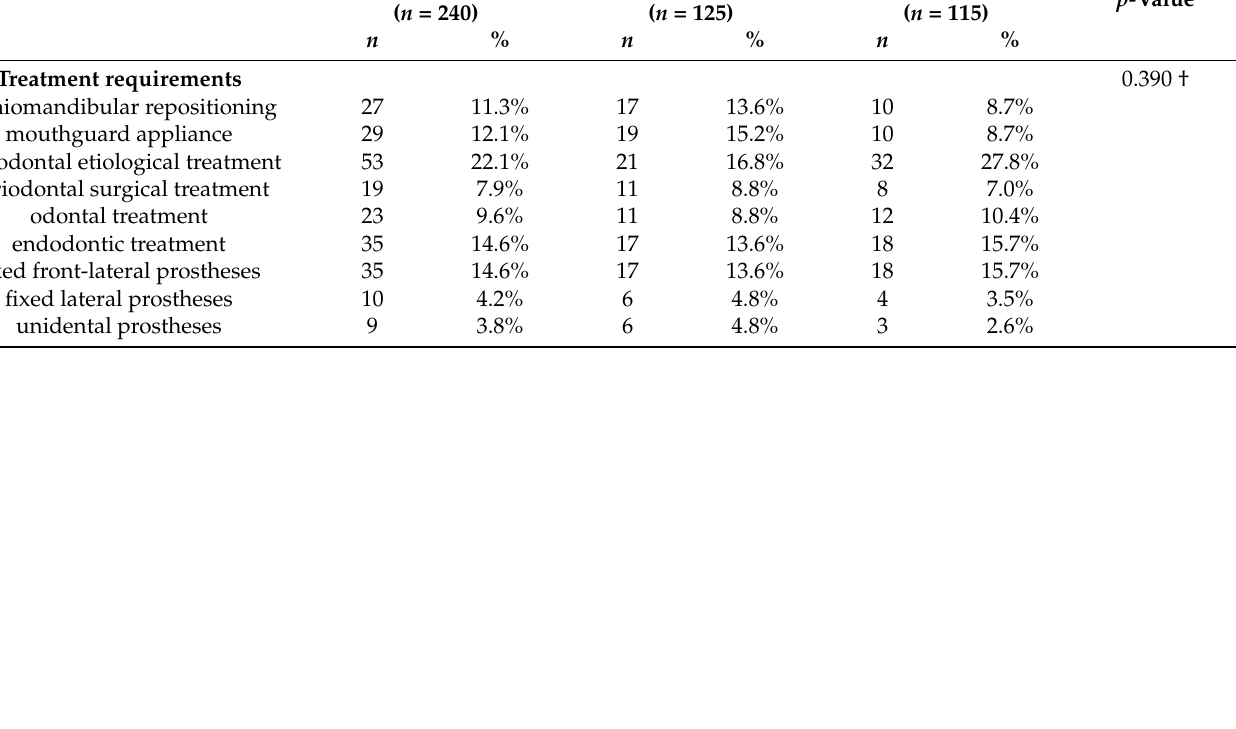
Table 8. Treatment requirements identified in the investigated samples. † Pearson Chi-squared test.